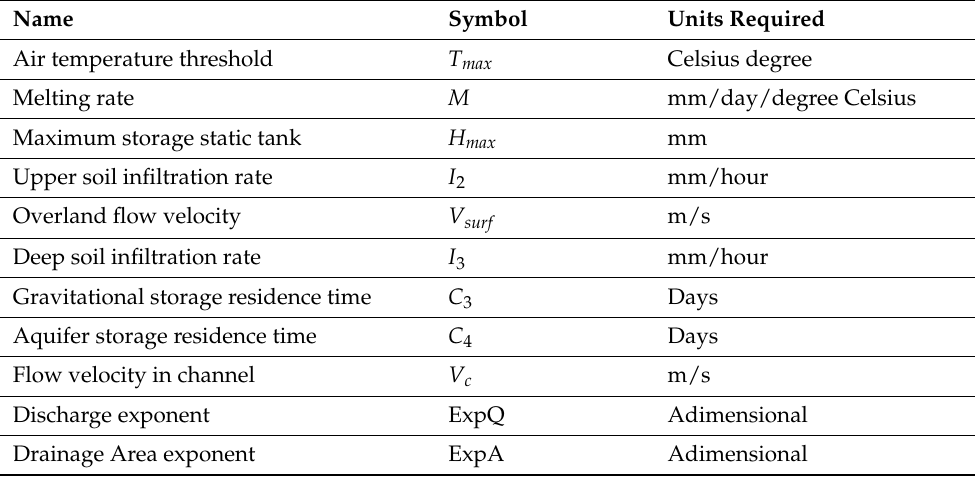
Table 1. Model parameter names, symbols and units required in